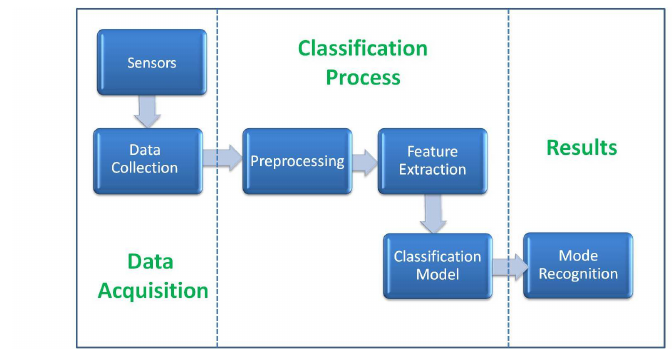
Figure 1. Overview of the classification process for mode recognition.